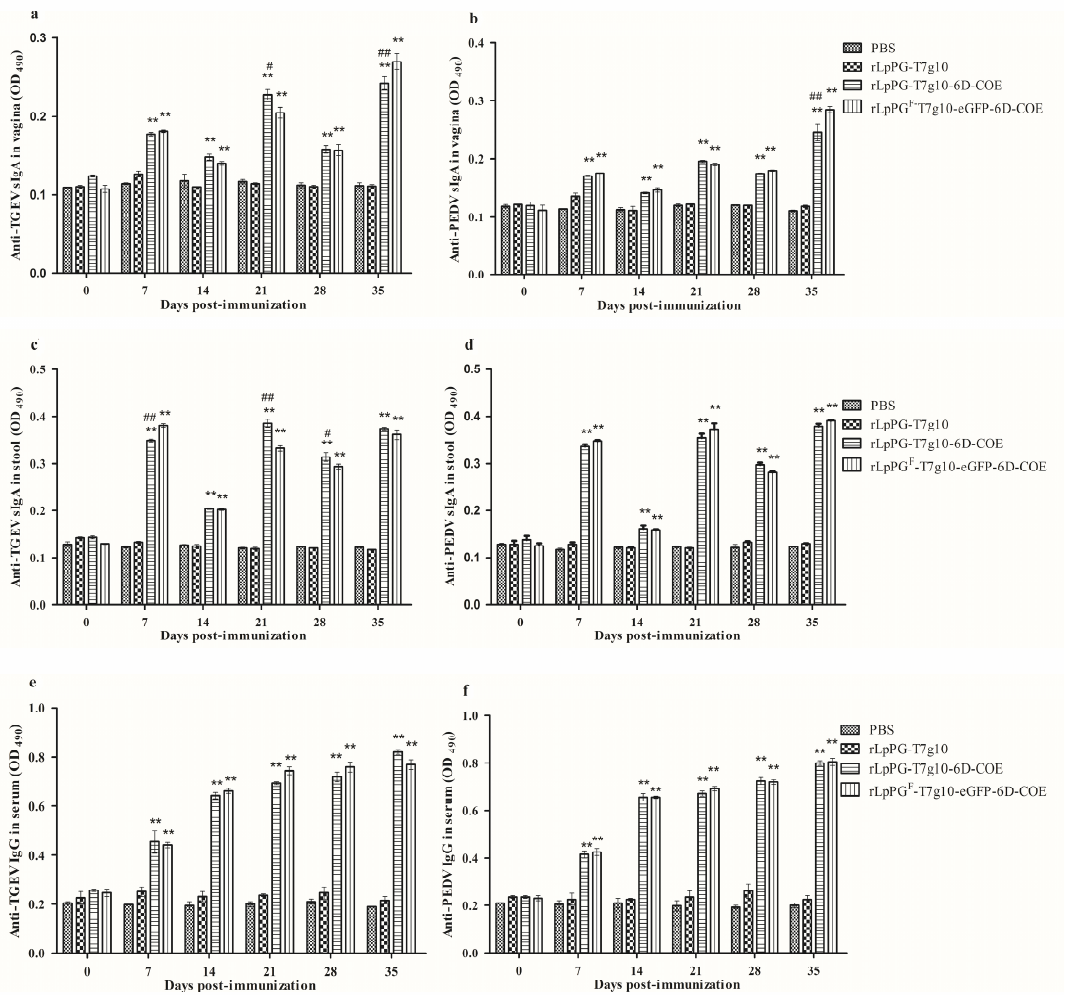
Figure 5. Levels of secreted immunoglobulin A (sIgA) and immunoglobulin G (IgG) in immunized mice. Transmissible gastroenteritis virus/porcine epidemic diarrhea virus (TGEV/PEDV)-specific sIgA antibody levels in the vagina ( a , b ) and the feces ( c , d ) post-immunization. Anti-TGEV IgG antibodies ( e ) and anti-PEDV-specific IgG antibodies ( f ) in immunized mice were detected at different time points. Bars represent the mean ± standard error of each group. * p < 0.05, ** p < 0.01 vs. phosphate-buffered saline (PBS) and vector control groups; # p < 0.05, ## p < 0.01 vs. rLpPG F -T7g10-eGFP-6D-COE group.